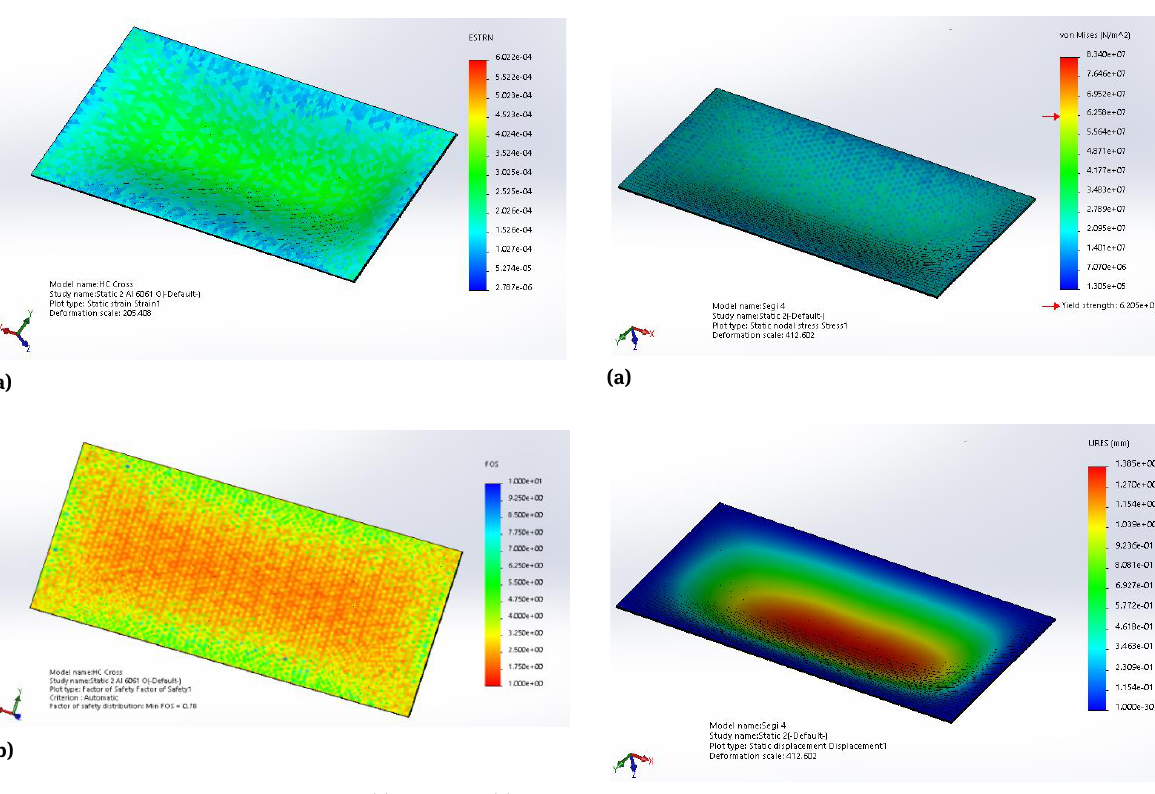
Figure 15: Results for the cross honeycomb: (a) strain and (b) safety factor N/mm 2 . The highest value of the resultant displacement is 1.39E+03 mm, as shown in Figure 16b.